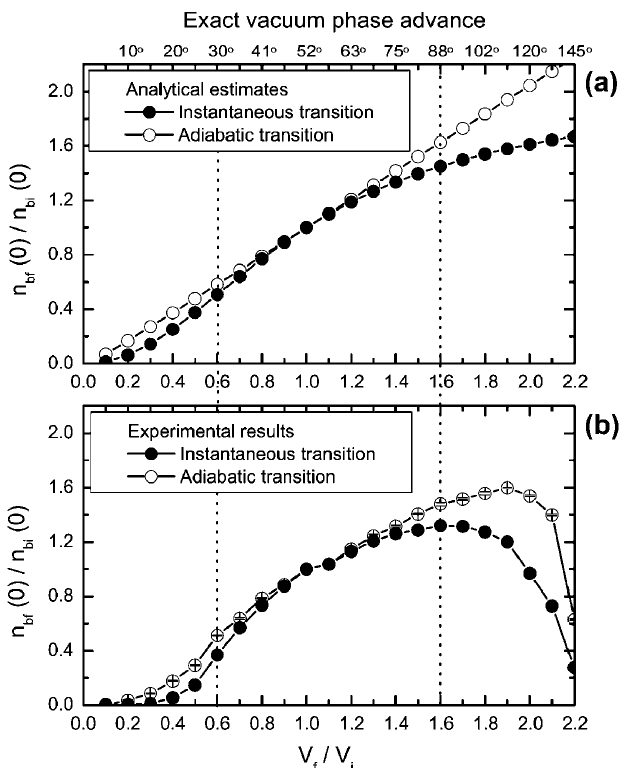
FIG. 3. Plots of the ratio of final to initial on-axis beam density (cid:6) 0 (cid:7) =n (cid:6) 0 (cid:7) for different values of V =V n with f (cid:3) 60 kHz bf bi f i (cid:6) 0 (cid:7) =n (cid:6) 0 (cid:7) are either (a) estimated from [20]. The values n bf bi analytical theory, or (b) measured experimentally. Here, the is 52 (cid:4) , which corre- initial exact vacuum phase advance (cid:4) vi (cid:3) 49 : 8 (cid:4) . Both instantaneous (solid circles) and sponds to (cid:4) sf v adiabatic (open circles) transitions are